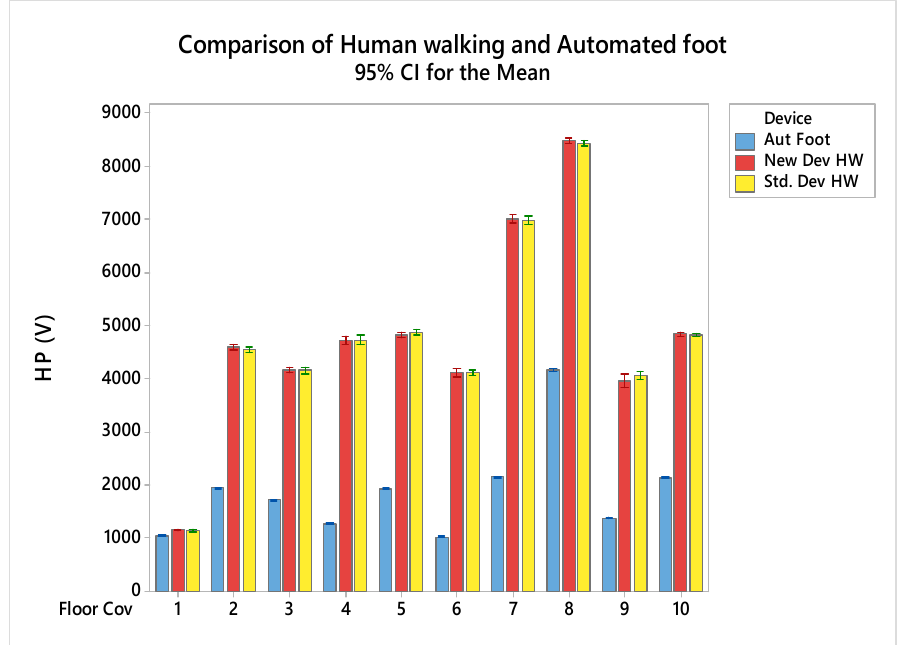
Figure 12. HP (Highest Peaks) graph that shows the comparison of automated foot device, and human walking mode devices.